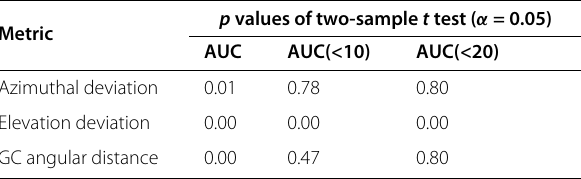
Table 11 Computed p values of two-sample t test at 0.05 significance level when comparing the best DOANet scheme against the best SCHC technique for in-flight tasks. GC great circle p values of two-sample t test ( α = 0.05) Metric AUC AUC(<10) AUC(<20) Azimuthal deviation 0.01 Elevation deviation 0.00 0.00